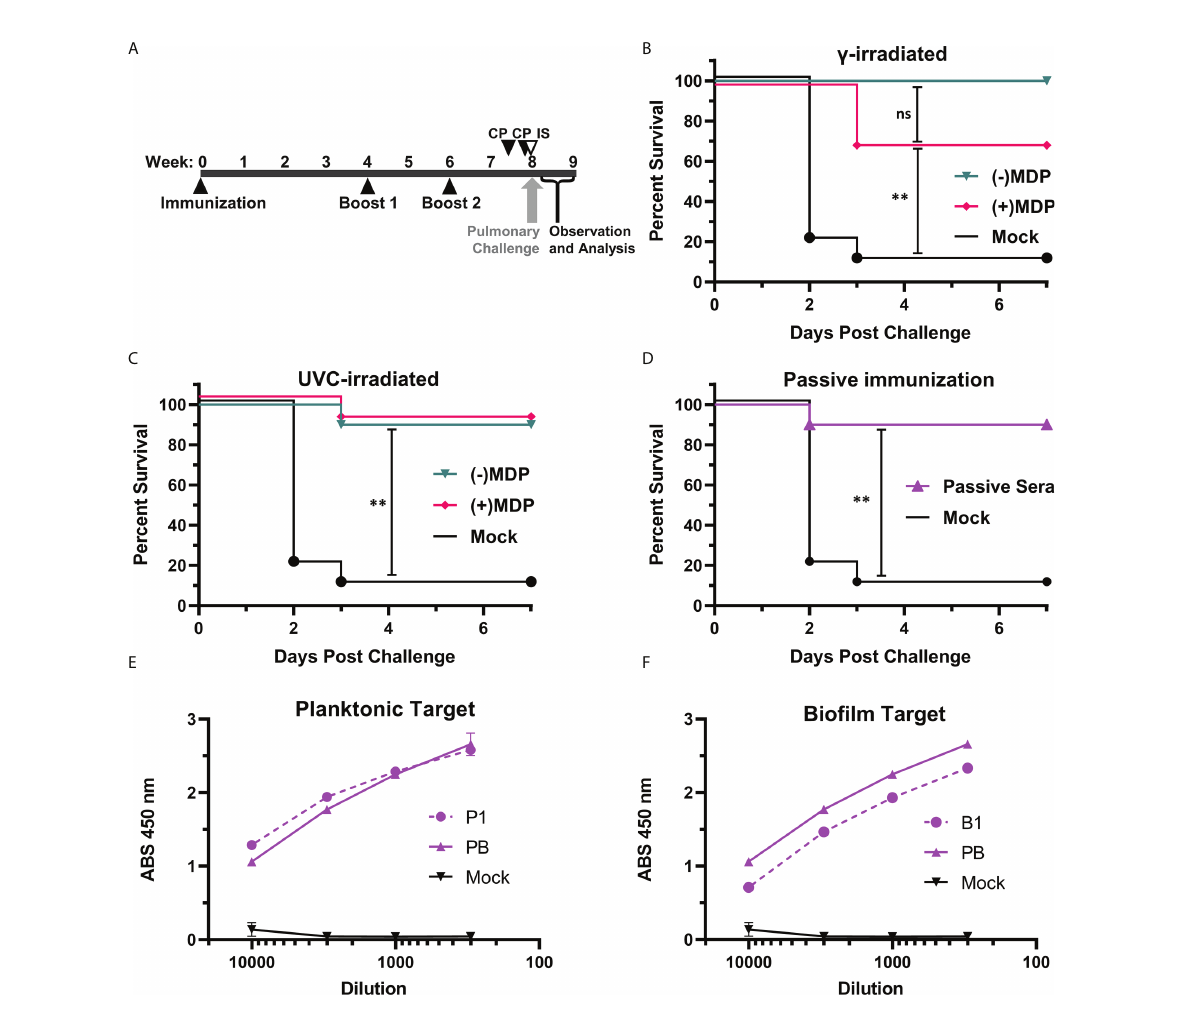
FIGURE 4 Pulmonary challenge in neutropenic mice. (A) Vaccination schedule. BALB/c mice, two independent groups of fi ve (10 total/per group) were vaccinated and boosted at weeks 4 and 6 post vaccination. Cyclophosphamide (CP) was given at days -4 and -1 pre-challenge. In one